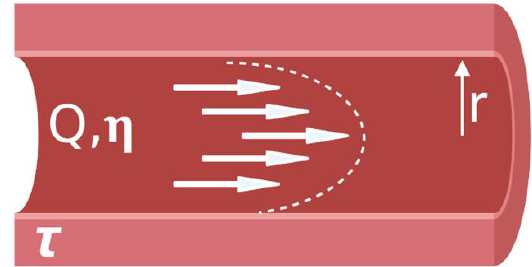
Figure 2. Parabolic shear stress profile in a blood vessel.